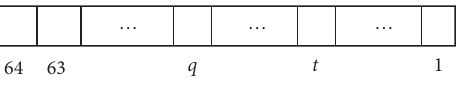
Figure 5: The schematics of numbered data